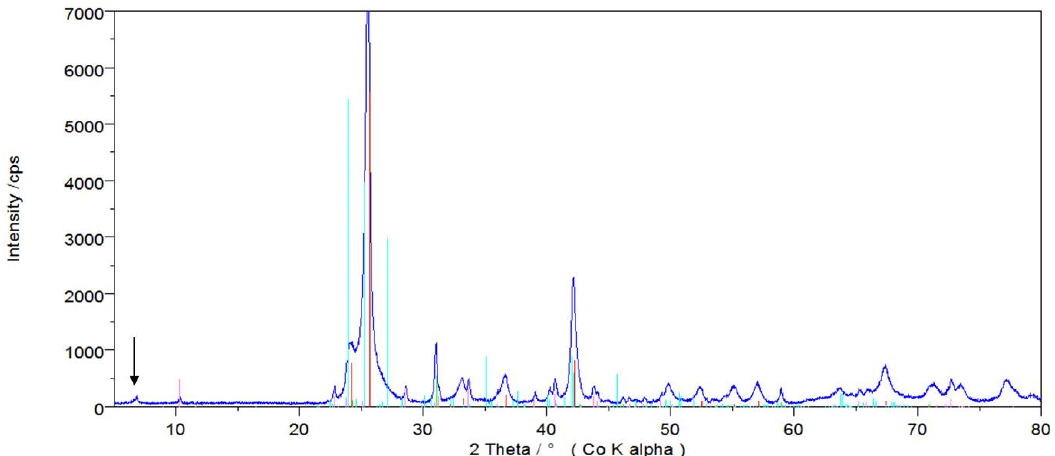
Figure 9. X-ray diffraction pattern of sample Jal 31 (powder sample, background corrected); search-match results in stick patterns: red: opal-CT (PDF 00-066-0177), light blue: tridymite (PDF 04-008-8127) as a proxy for more “tridymitic“ opal-CT, for comparison only, green: quartz (PDF 01-075-8322); the arrow points to the d 001 of smectite with 1.498 nm. Samples Jal 32 and Jal 33 provide further information about the microstructure of the filaments from the quarry area of Jalgaon / Savda (Figure 10). Sample Jal 33 represents a cross-section of two conical filaments with dark brown cores (Figure 10a). The core is encrusted by a concentric succession of silica layers with varying grain size (Figure 10c) and textural characteristics indicating changes in the physicochemical conditions during crystallization. The outermost filament layer of several 100- µ m thickness is composed of macro-crystalline quartz. The short-lived bluish CL (Figure 10e,f) is characteristic for quartz crystallized from aqueous solution at elevated temperatures. Details of the filamentous core (Figure 10d) reveal an Fe-rich composition (high BSE contrast) and an irregular texture with dissolution features. The chemical composition is similar to that of the core of sample Jal 30 dominated by Si, Fe, Mg, and Al (see Table